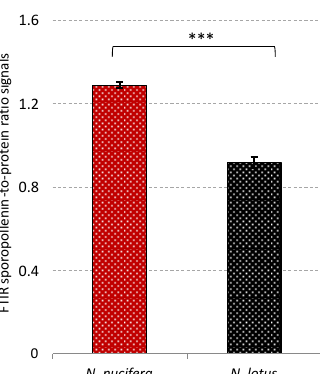
Figure 5. Typical Fourier transform infrared (FTIR) spectra of pollen from N. nucifera and N. lotus ( a ); specific bands possibly used for N. nucifera and N. lotus pollen authentication ( b ); FTIR sporopollenin-to-protein ratio signals (at 883 cm −1 and 1659 cm −1 , respectively) for N. nucifera and N. lotus pollen authentication ( c ). *** significant p < 0.001.